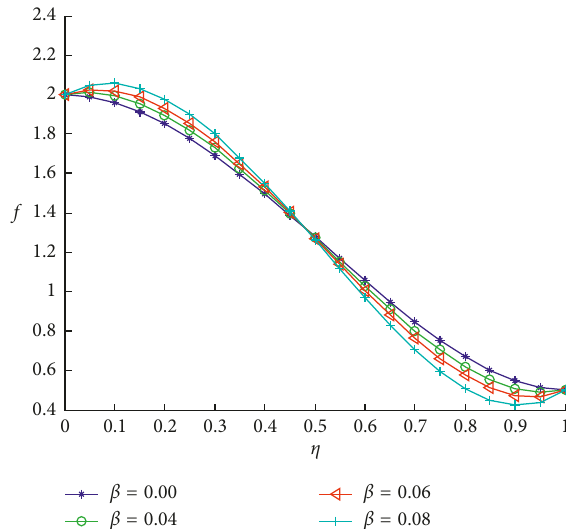
Figure 5: Effect of the slip parameter on the velocity profile Nb Pr when A 2 ,S 1 ,Nt 0 . 2 , c 0 . 1 ,M 0 . 5 ,Le 1 . 0 , (cid:31) (cid:31) (cid:31) (cid:31) (cid:31) (cid:31) (cid:31) (cid:31) and C